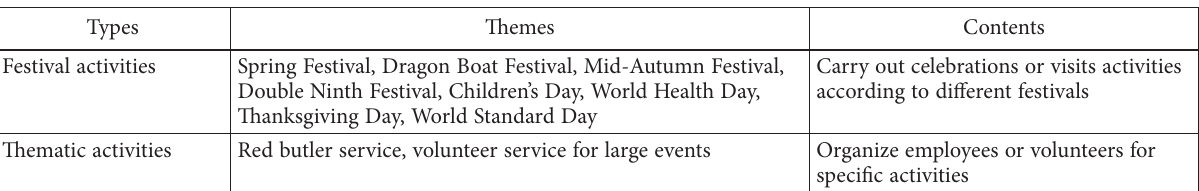
Table 5. The types, themes and contents of activities to fulfill social responsibilities